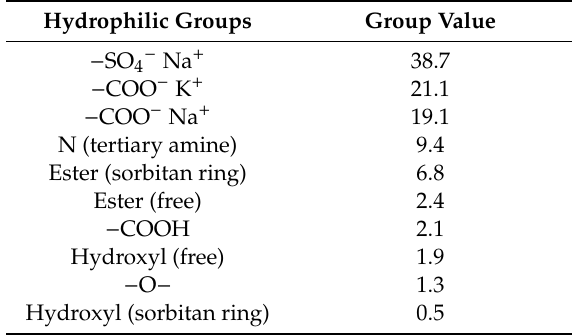
Table 2. Types of hydrophilic groups and their corresponding values.